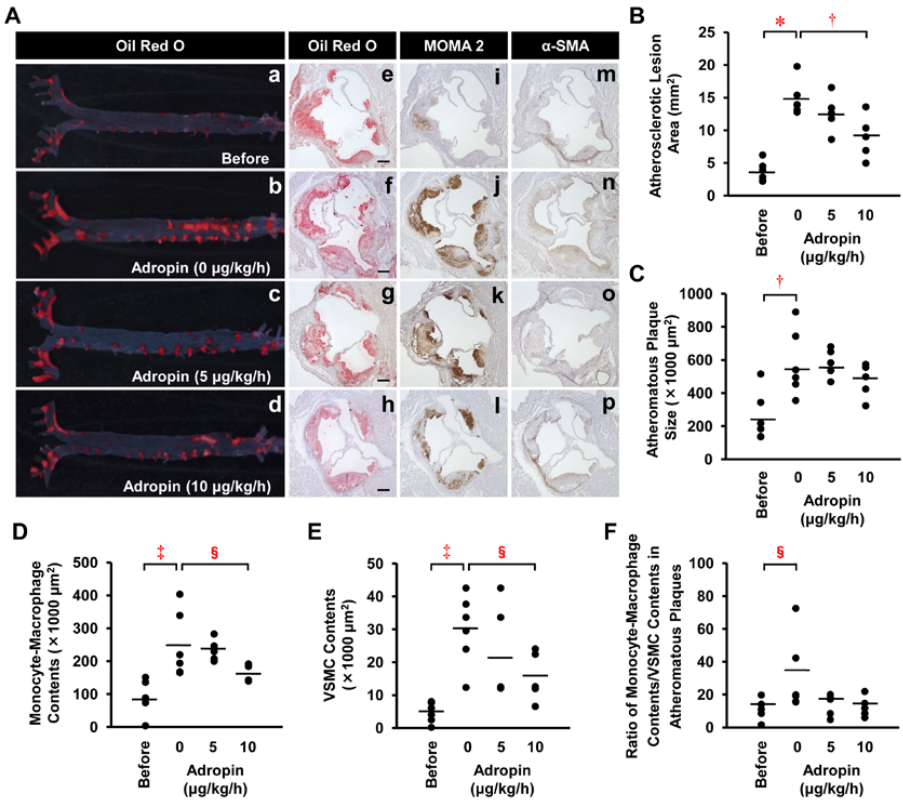
Figure 6. Effects of adropin on atherosclerotic lesion development in Apoe − / − mice. Of the 22 Apoe − / − mice at 17 weeks of age, six were sacrificed before infusion and six, five, and five were infused with adropin at doses of 0, 5, and 10 μg/kg/h using osmotic minipumps for 4 weeks. ( A ) The atherosclerotic lesions on the aortic internal surface were stained with Oil Red O (a–d). Cross-sections of the aortic sinus were stained with Oil Red O (e–h), with immunostains for monocyte-macrophage 2 (MOMA2; (i–l)) or α -smooth muscle actin ( α -SMA; (m–p)). Scale bar = 200 µ m. ( B – F ) Statistical comparisons of atherosclerotic lesion area, atheromatous plaque size, monocyte-macrophage or VSMC contents, and the ratio of monocyte-macrophage contents/VSMC contents within atheromatous plaques among four groups. * p < 0.0001, † p < 0.005, ‡ p < 0.0005, § p < 0.05. Bars indicate the mean values in the graphs. Table 1. Characteristics and laboratory data of Apoe − / − mice.